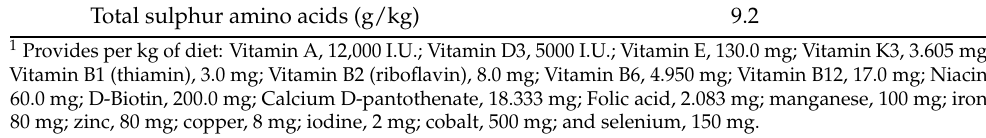
Table 1. Cont. Items (g/kg) Total sulphur amino acids (g/kg)